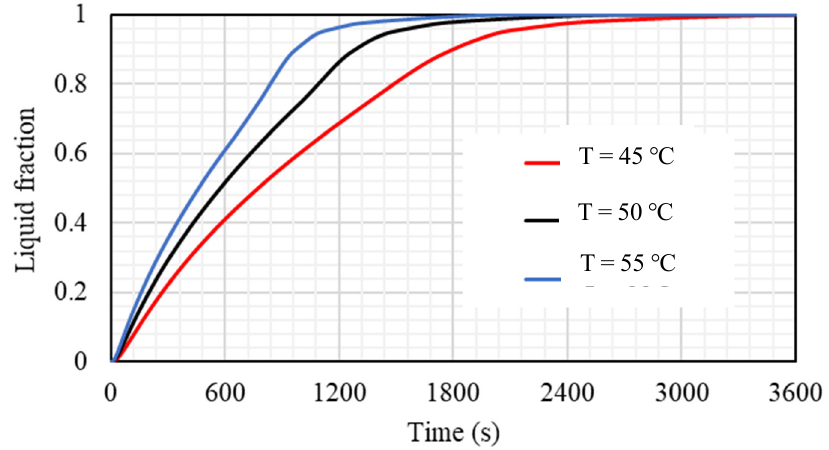
Figure 17. The liquid fraction development for the total PCM for the case 3b (Re equals 1000) at different values of inlet HTF temperature (Tin = 45 °C, Tin = 50 °C, and Tin = 55 °C).